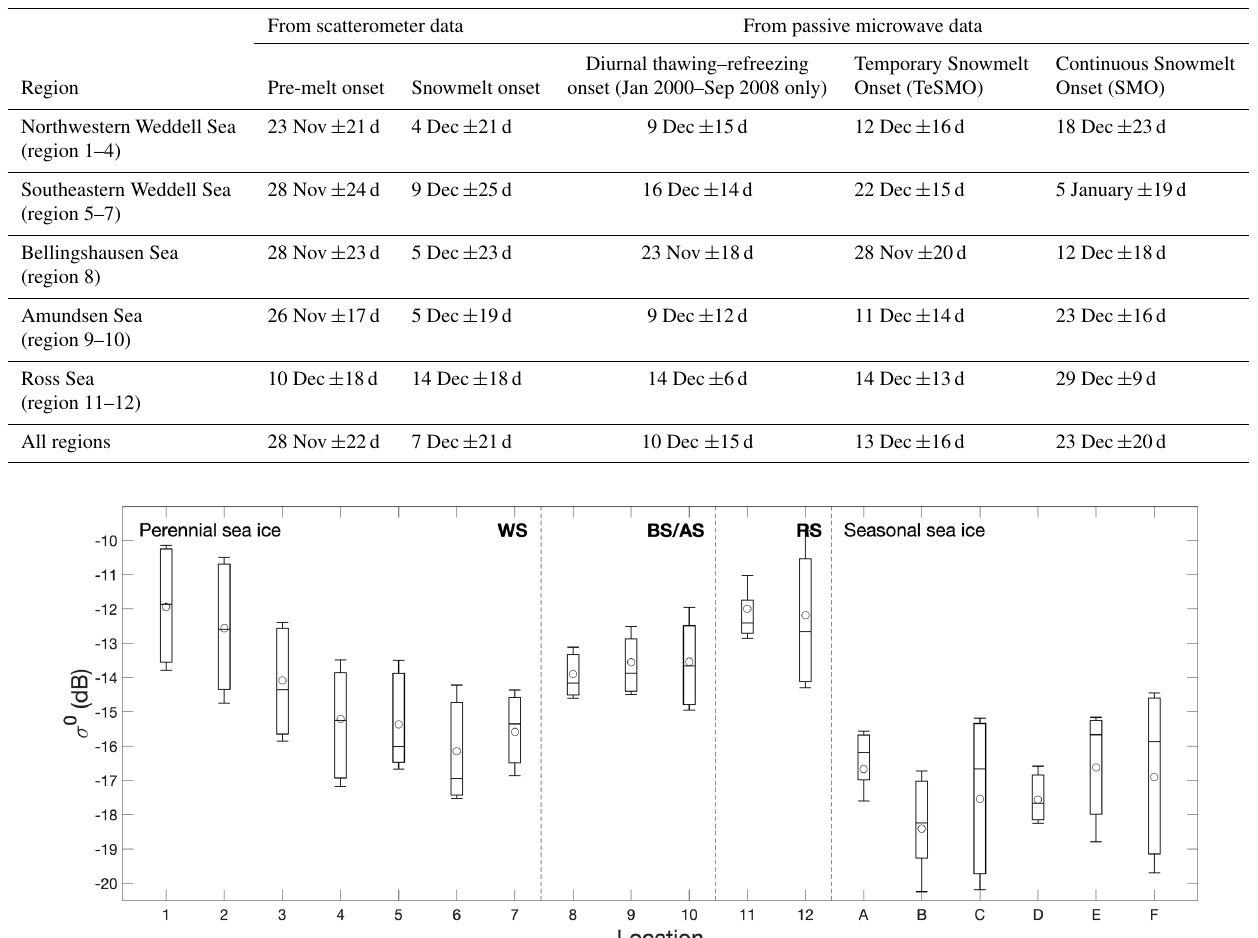
Table 1. Mean snowmelt onset dates indicated in Fig. 2 for the 12 study locations on perennial sea ice shown in Fig. 1 (mean ± 1 standard deviation).